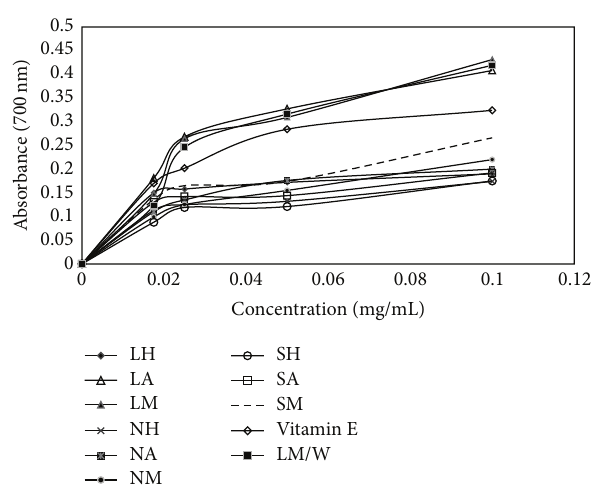
Figure 3: Reducing power of extracts from O. europaea organs.